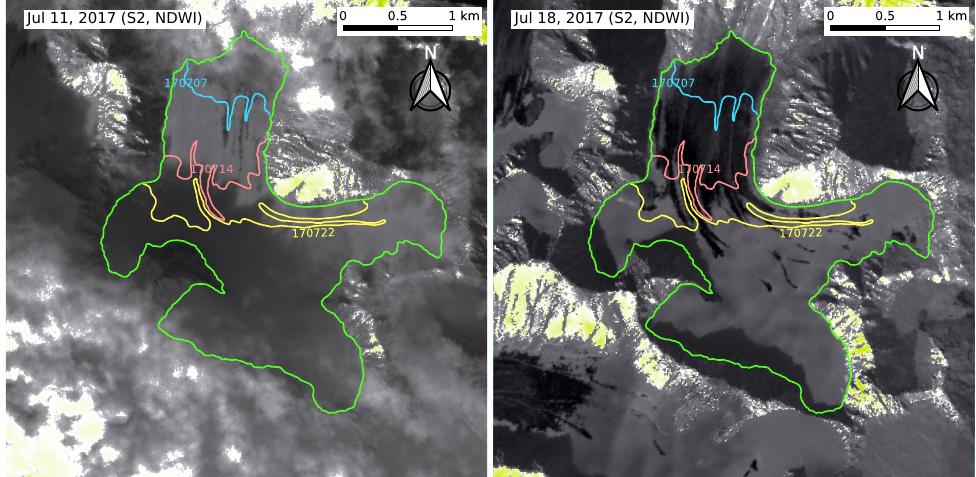
Figure 6. Evolution between 11 July ( left ) and 18 July ( right ) 2017 of the snowpack as observed from the spaceborne Sentinel-2 multispectral imaging sensor. The FSC boundaries were drawn from the ground-based pictures collected 7 (blue), 14 (pink) and 22 (yellow) July. The green boundary outlines the glacier basin. The extent of both snow cover fraction using both techniques seems